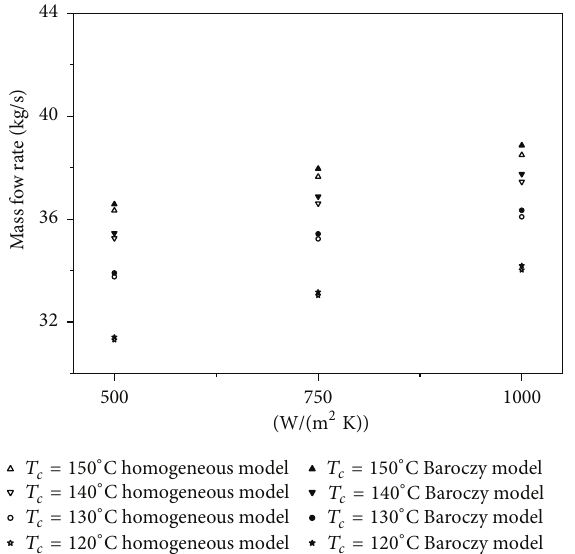
Figure 7: Mass flow rate evaluated based on different two-phase frictional pressure drop models.